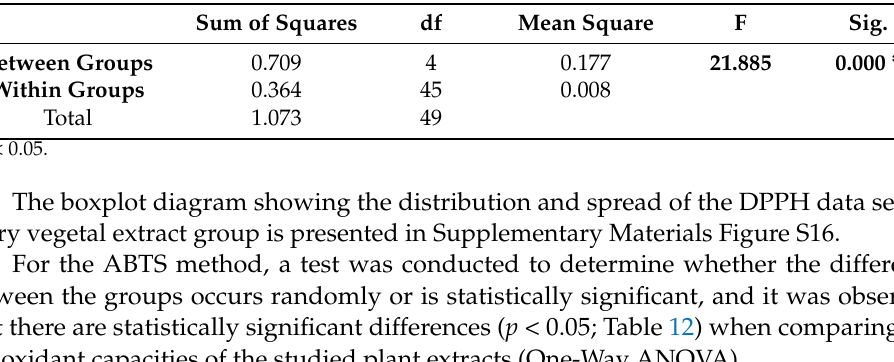
Table 12. The comparison with ANOVA Test (Antioxidant Inhibition ABTS). Sum of Squares df Mean Square F Sig. Between Groups 0.246 4 0.061 15.960 0.000 * Within Groups 0.173 45 0.004 Total 0.419